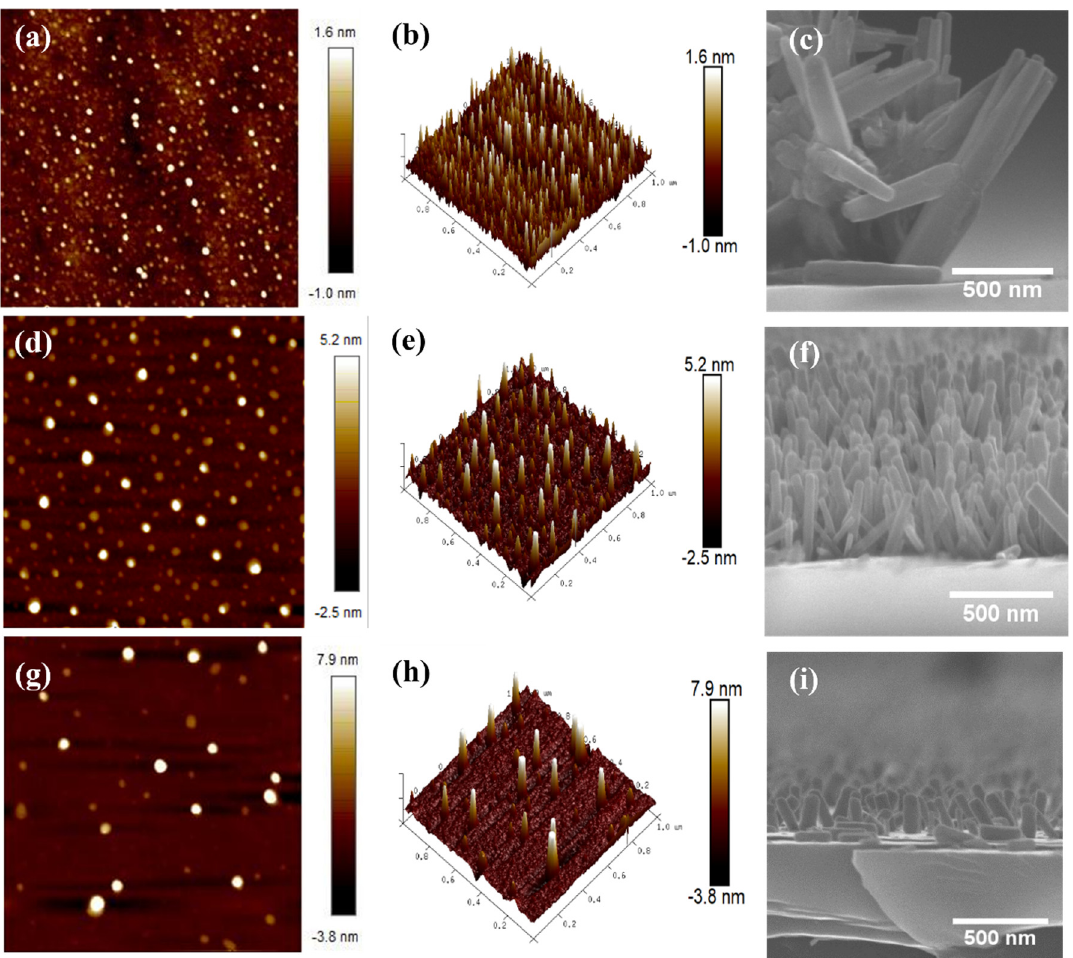
Figure 5. AFM images of ZnO seed layer on different thicknesses: ( a , b ) one ‐ layer sample; ( d , e ) three ‐ layer sample; ( g , h ) five ‐ layer sample. FESEM cross ‐ section view ( c , f , i ) images of ZnO nanowires.